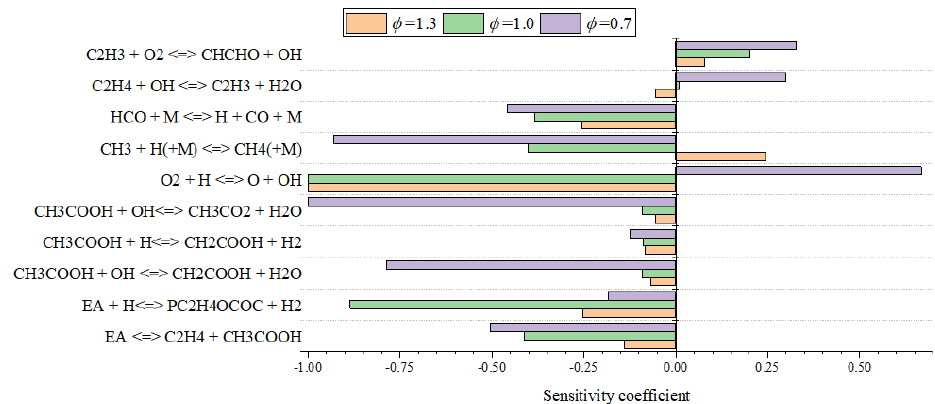
Figure 9. Sensitivity coefficient of EA consumption at φ = 0.7, 1.0, and 1.3.